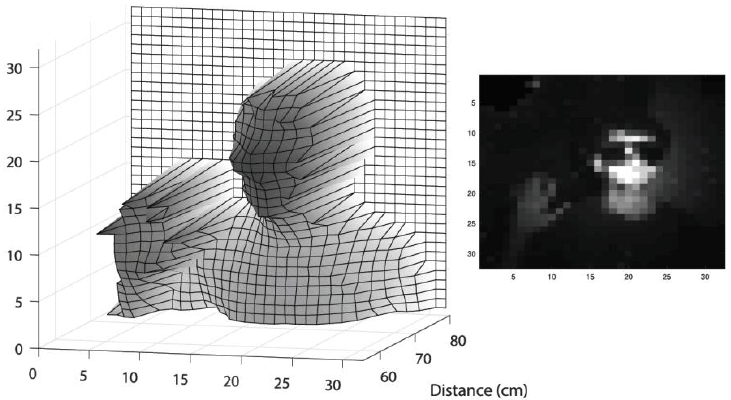
Figure 15. Flash 3D imaging of a human subject at distance of 0.7 m with 2D intensity image inset.